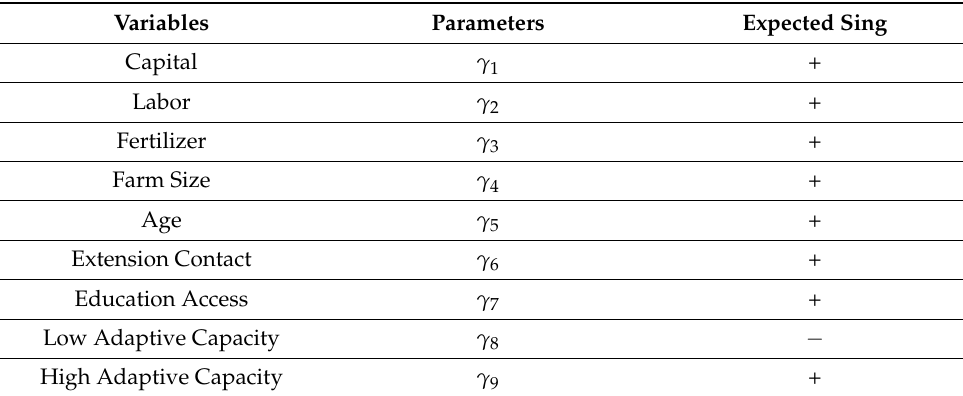
Table 3. Expected sign of the independent